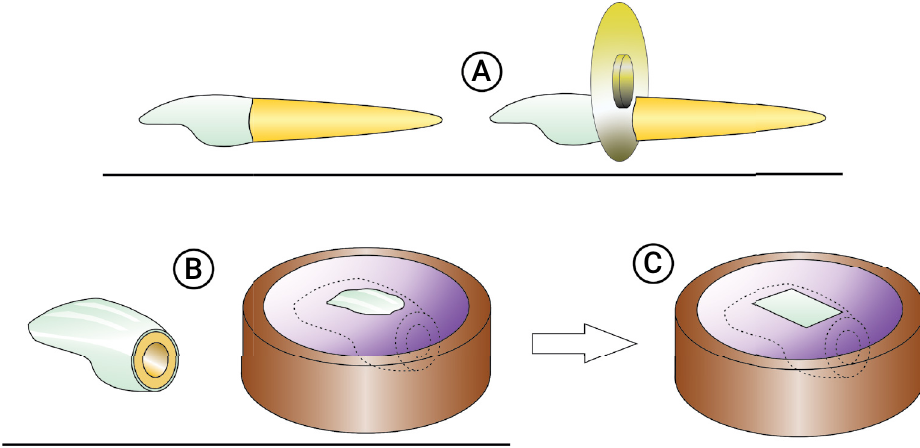
Figure 1. Specimen preparation: A – root removal; B – tooth embedding in chemically cured acrylic resin; C – grinding and polishing of the specimen´s buccal